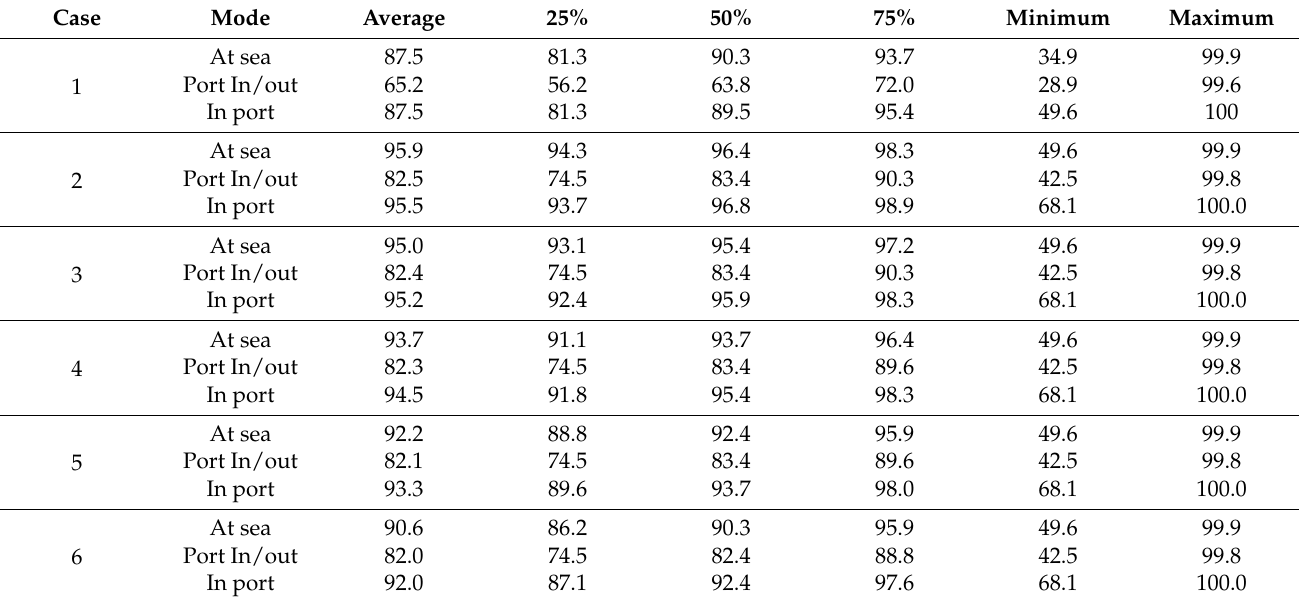
Table 6. Generator efficiency in each case.